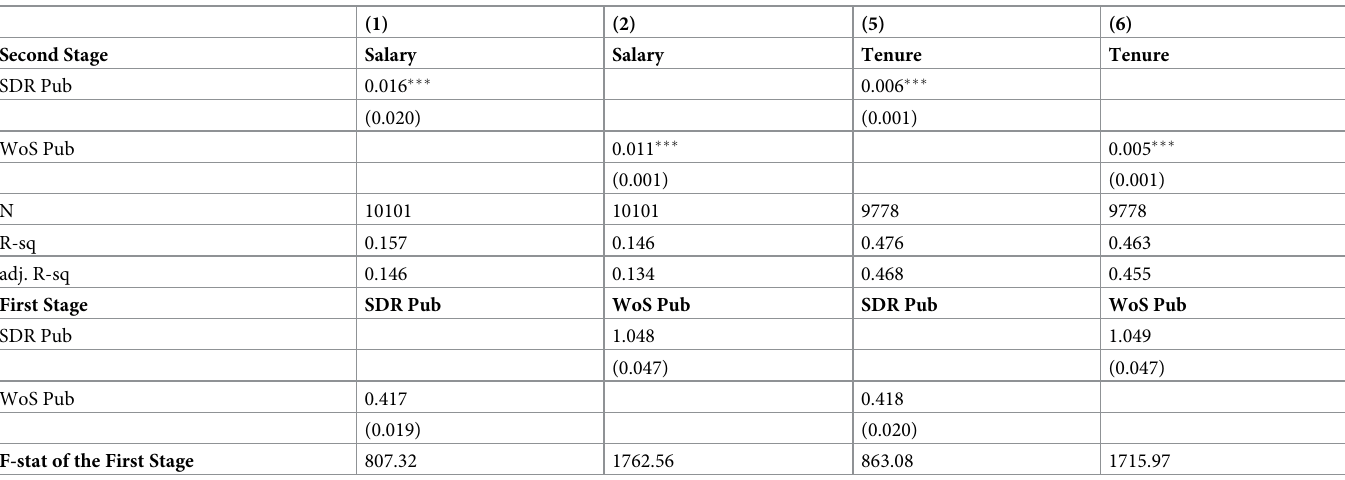
Table 4. Instrumental variables